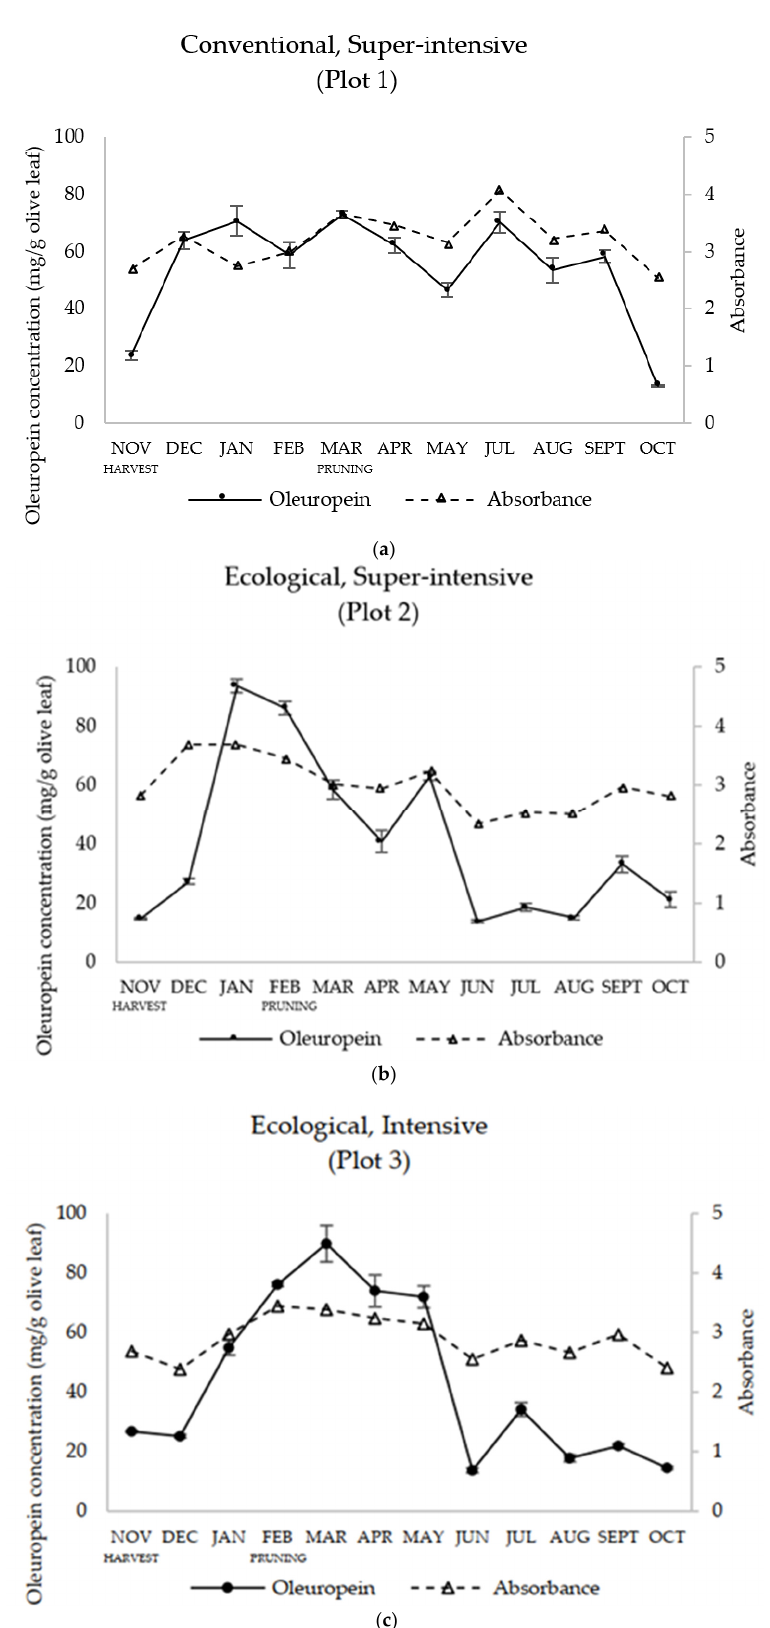
Figure 2. Evolution of oleuropein (mg/g) and absorbance at 280 nm of olive leaves cv. Arbequina during an agronomic cycle (November 2019 to October 2020). ( a ) Plot 1: Conventional and super- intensive; ( b ) Plot 2: Ecological and super-intensive; ( c ) Plot 3: Ecological and intensive. The highest oleuropein concentration was observed in March in P1, 73.03 mg/g, coinciding with the pruning season, and in January in the ecological system, 93.57 mg/g, coinciding with the pre-pruning season. From May to October, coinciding with the summer and autumn seasons, content tended to decrease in P2, declining to 13.85 mg/g in June. On the contrary, in P1, oleuropein content remained more stable until September, decreasing considerably in October to 13.09 mg/g. In both plots was observed a similar trend for the oleuropein content, which was lower in leaves collected in autumn (October) than those collected in spring (March). Regarding the other phenolic compounds (Figure 3a,b), the maximum verbascoside content in P1 was 21.97 mg/g (post-pruning), while in P2, it was 6.50 mg/g (pruning).